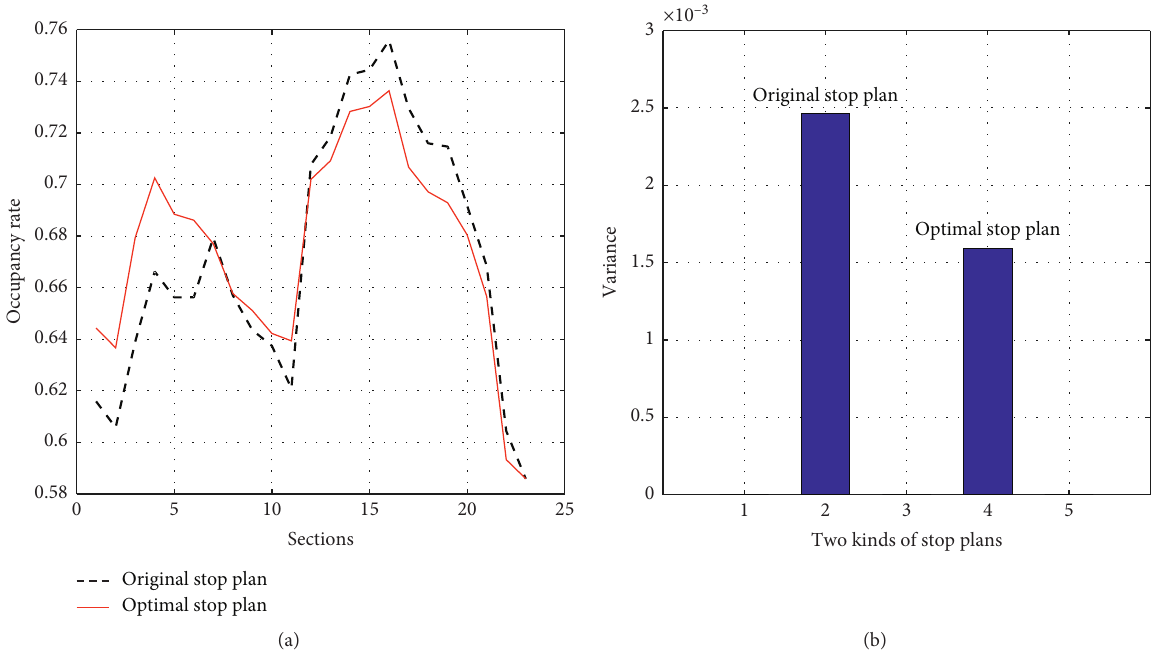
Figure 9: Occupancy rates of each section for original and new approaches.